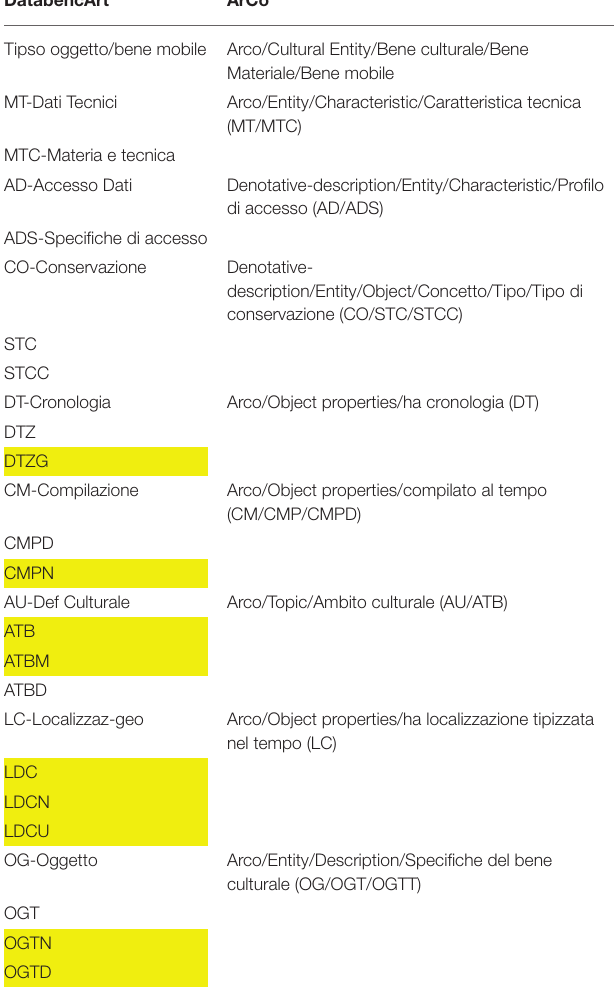
TABLE 2 | Correspondences between the fields of the DatabencArt RA type record and the ArCo ontology nodes and properties. DatabencArt